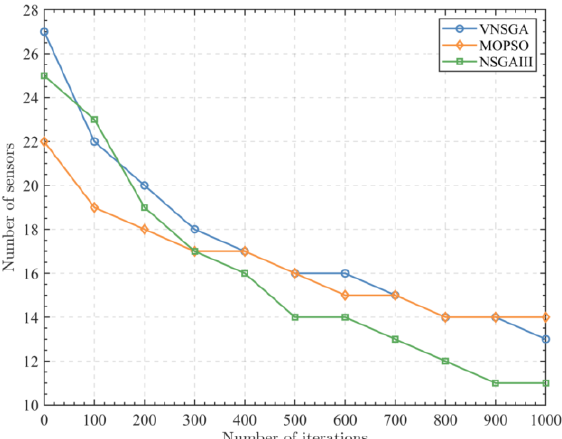
Figure 19. Number of sensors for three algorithms from different iterations for 50 m R s max and 100 m R c max with respect to area A.